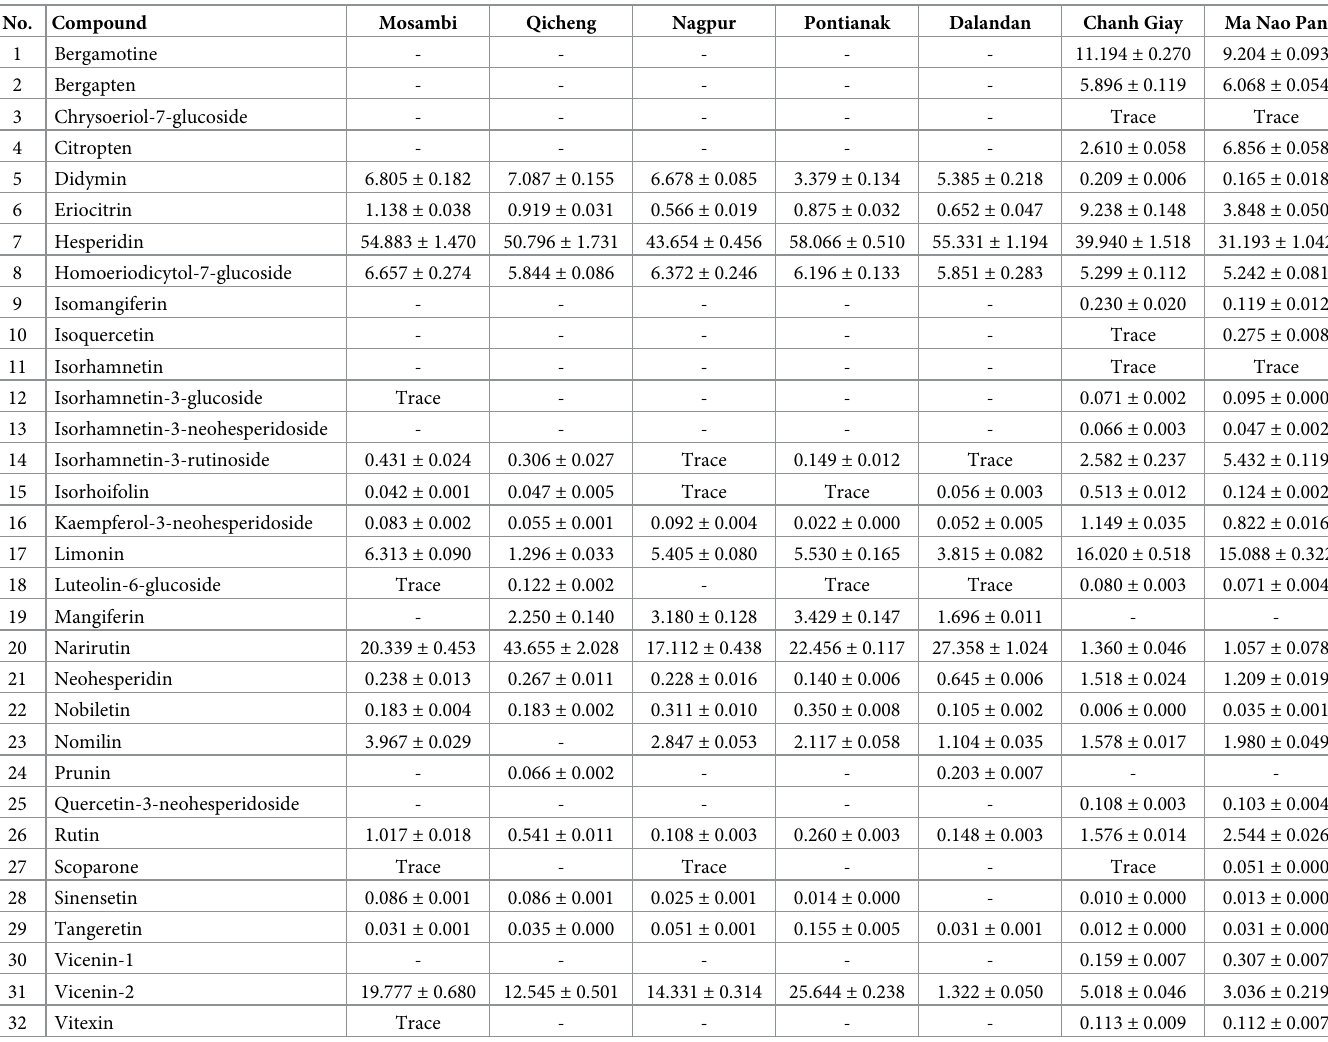
Table 2. Flavonoids, limonoids and coumarin compounds in citrus juice identified and quantified by LC-QTOF/MS (concentrations expressed in μ